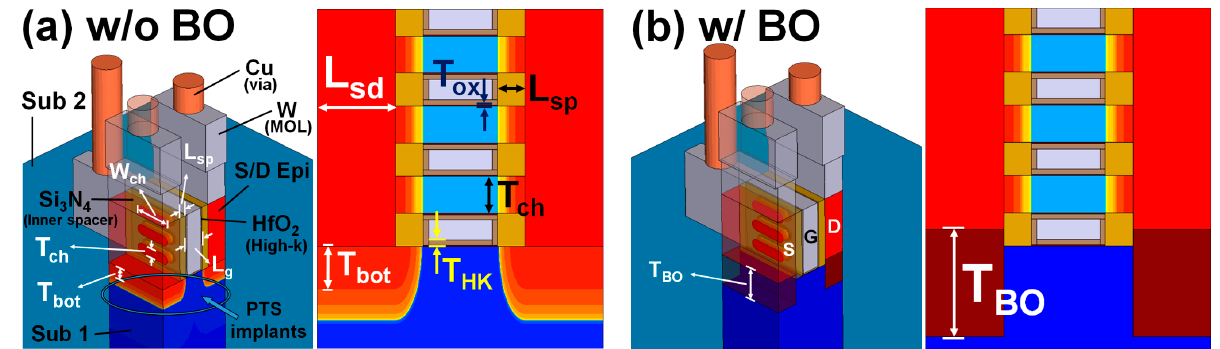
Figure 1. ( a ) 3D structure and cross section view of mNS-FET with PTS doping scheme, ( b ) 3D struc- ture and cross section view of mNS-FET with bottom isolation scheme. Table 1. Geometrical parameters for multi-nanosheet channel FET.